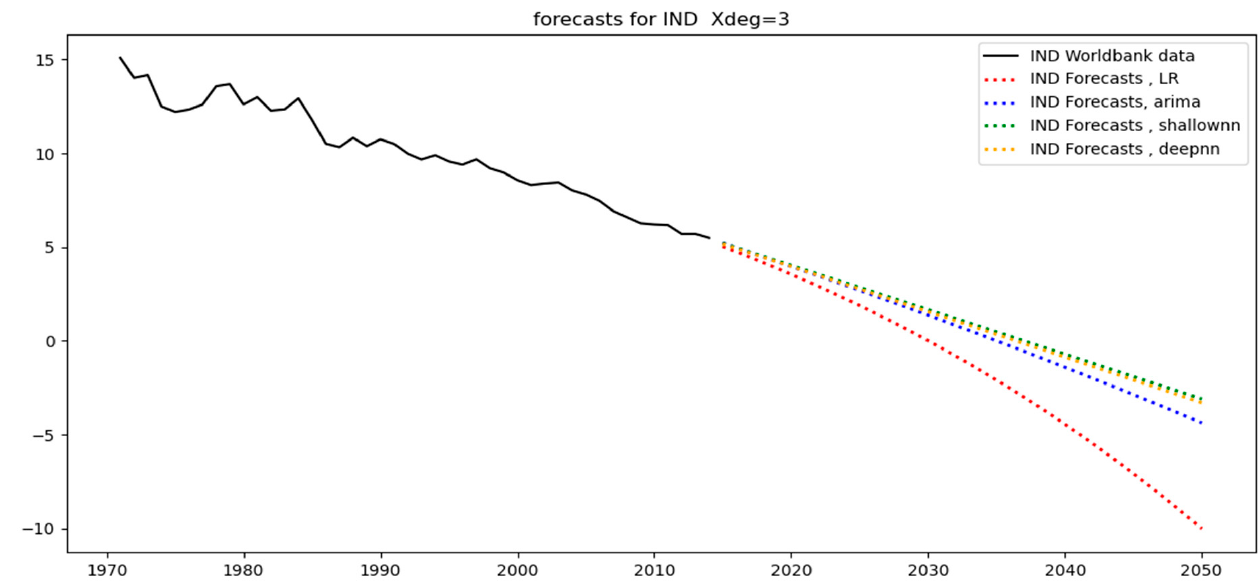
Figure 13. Forecasts for India (IND), using linear regression (LR), ARIMA, shallow neural networks (shallownn), and deep neural network (deepnn) models (third-degree polynomial).